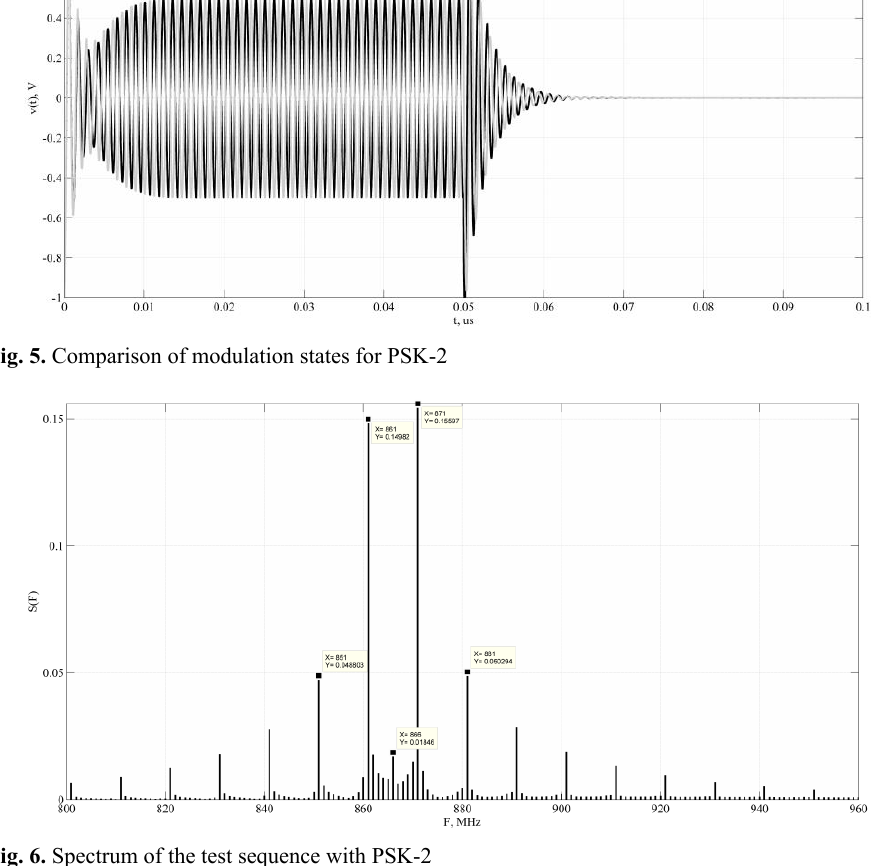
Fig. 6. Spectrum of the test sequence with PSK-2